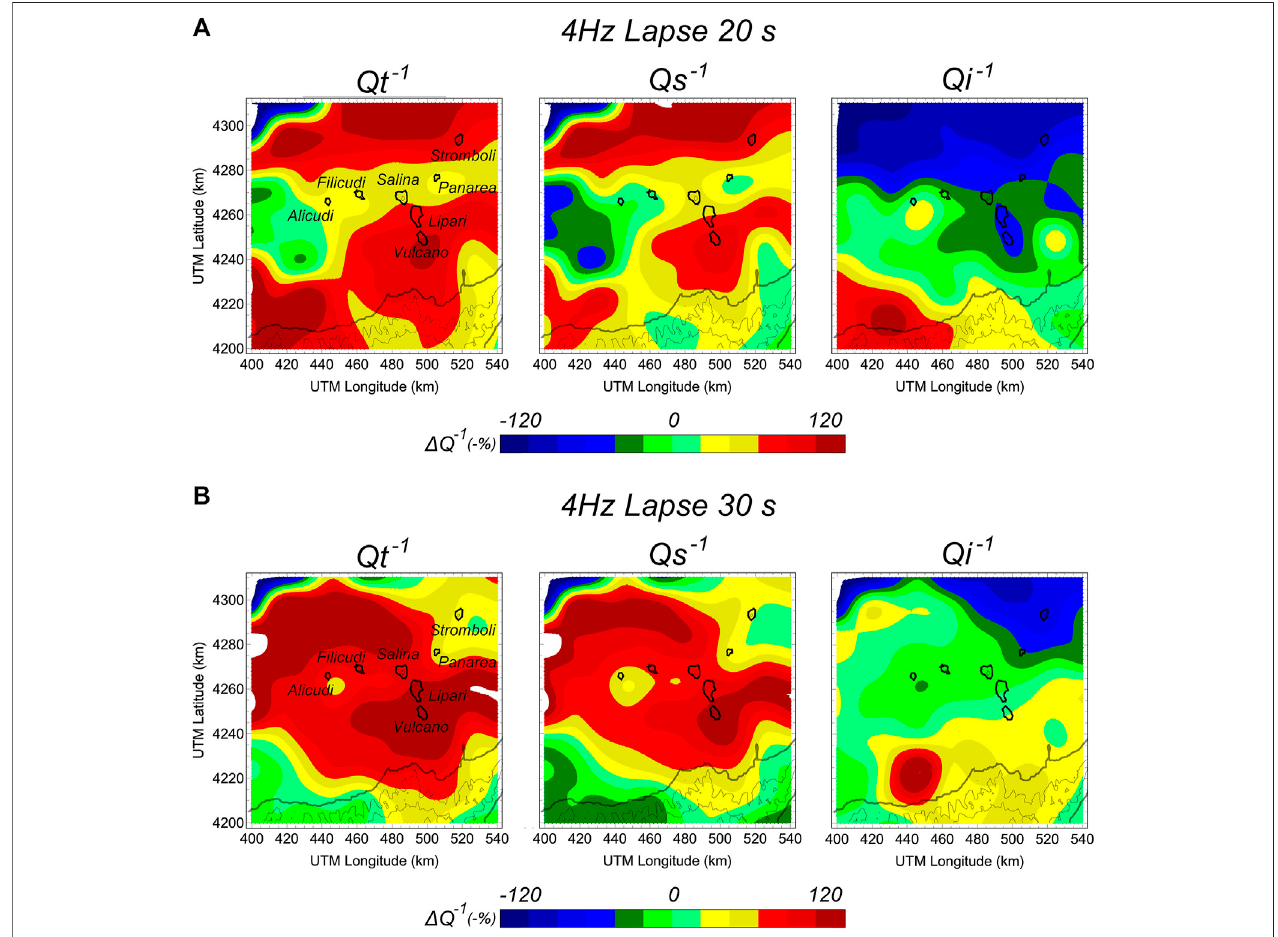
FIGURE 7 | Attenuation anomaly maps of intrinsic, scattering, and total attenuation (represented by Q − 1 ) for a frequency of 4 Hz. Maps are given for two lapse times: (A) 20 s and (B) 30 s.